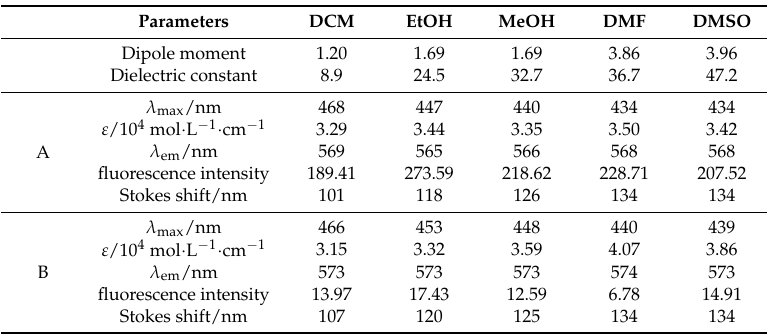
Figure 3. Spectra of the fluorescent probe A and probe B in MeOH, EtOH, DCM, DMF, and DMSO solvents, respectively (UV-Vis absorbance spectra of probe A ( a ) and probe B ( c ); and fluorescence emission spectra of probe A ( b ); and probe B ( d )). Table 1. Spectra data of probe A and probe B in different solutions.